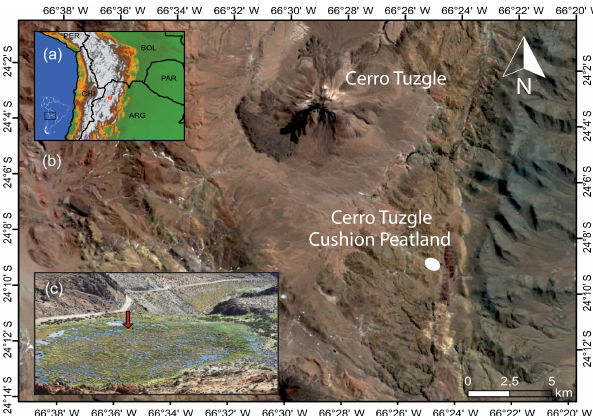
Figure 1. Panel (a) : map of NW Argentina and adjacent coun- tries (data source: GLCF World Data). Panel (b) : the location of Cerro Tuzgle peatland (CTP) south of Cerro Tuzgle volcano in the NW Argentine Puna plateau (data source: DGM-GTOPO30). Panel (c) : panorama of the Oxychloe andina -dominated part of CTP and the location of the coring site (February